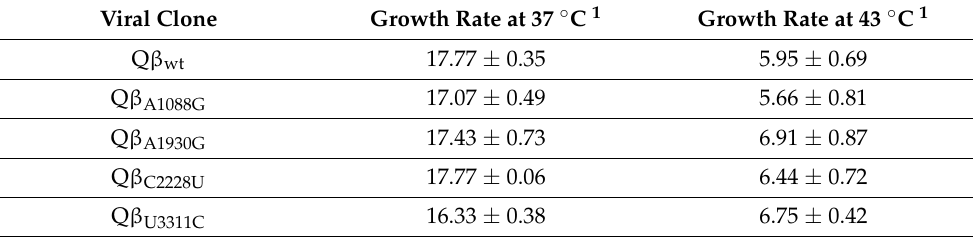
Table 4. Growth rate values at 37 and 43 ◦ C of virus Q β wt and several Q β single mutants.